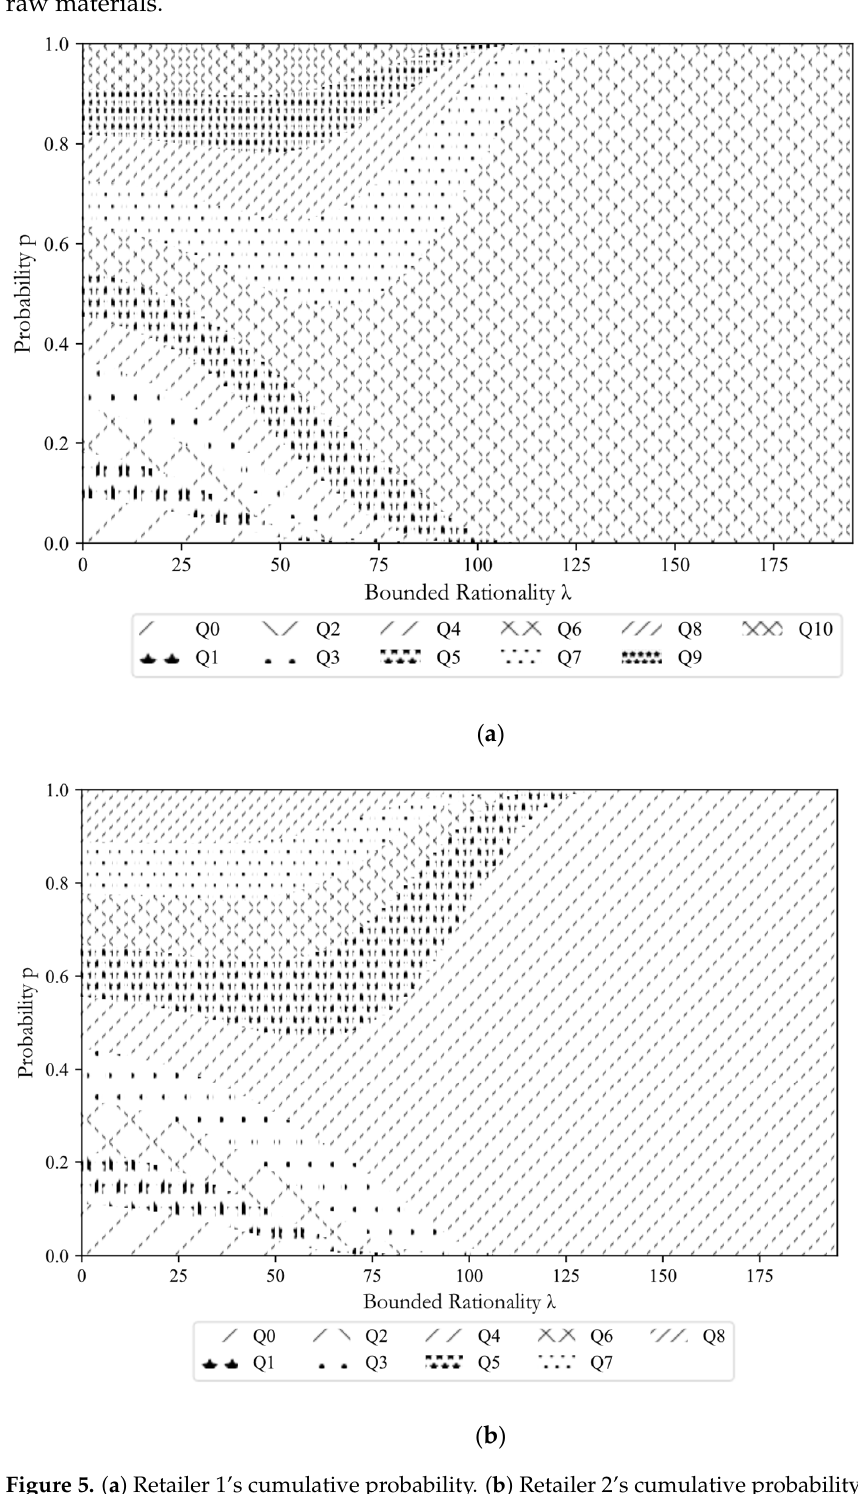
Figure 5. ( a ) Retailer 1’s cumulative probability. ( b ) Retailer 2’s cumulative